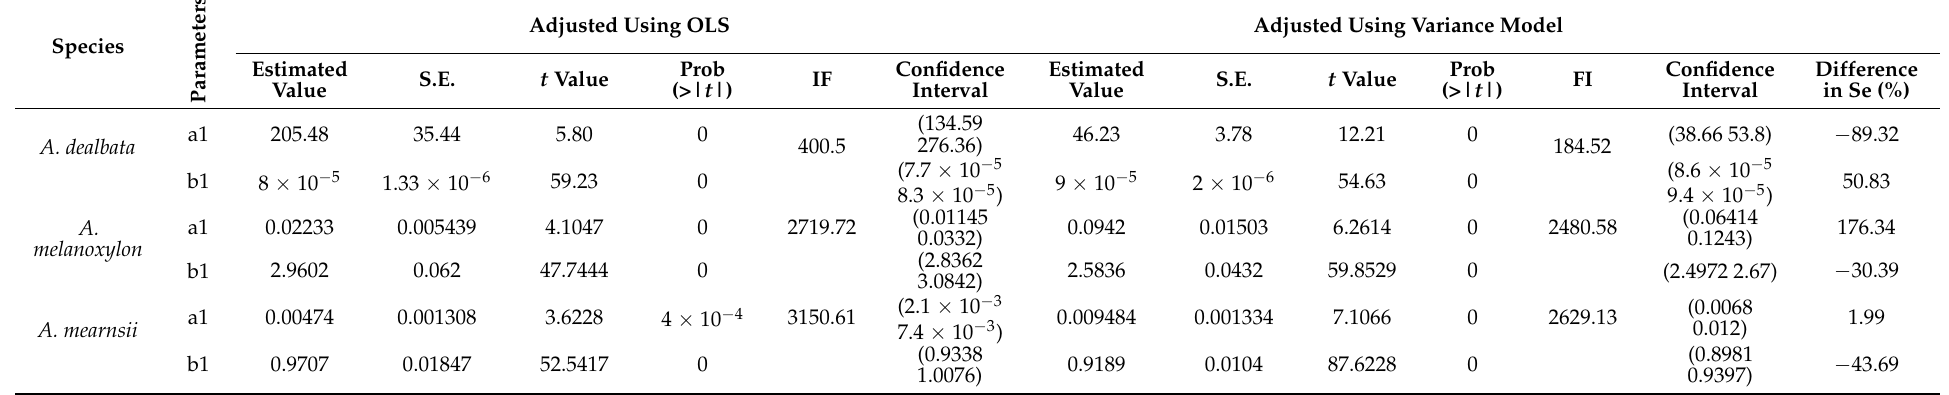
Table 3. Heteroscedasticity in the estimation of the total biomass of A. dealbata , A. melanoxylon , and A. mearnsii